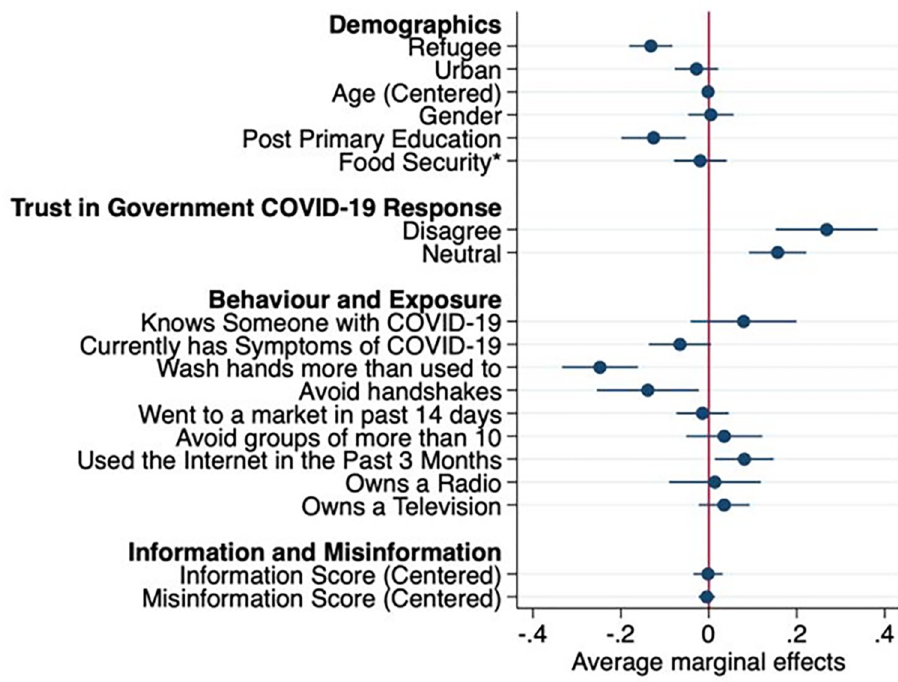
Fig 1. Marginal effects of key variables on vaccine hesitancy, adjusted for interactions. Marginal effects were calculated based on an adjusted logistic regression which can be found in S2 Appendix. � the exact wording of the food security question is “during the last 30 days, was there a time when you or any other adult in your household were hungry but did not eat because there was not enough money or resources for food”.